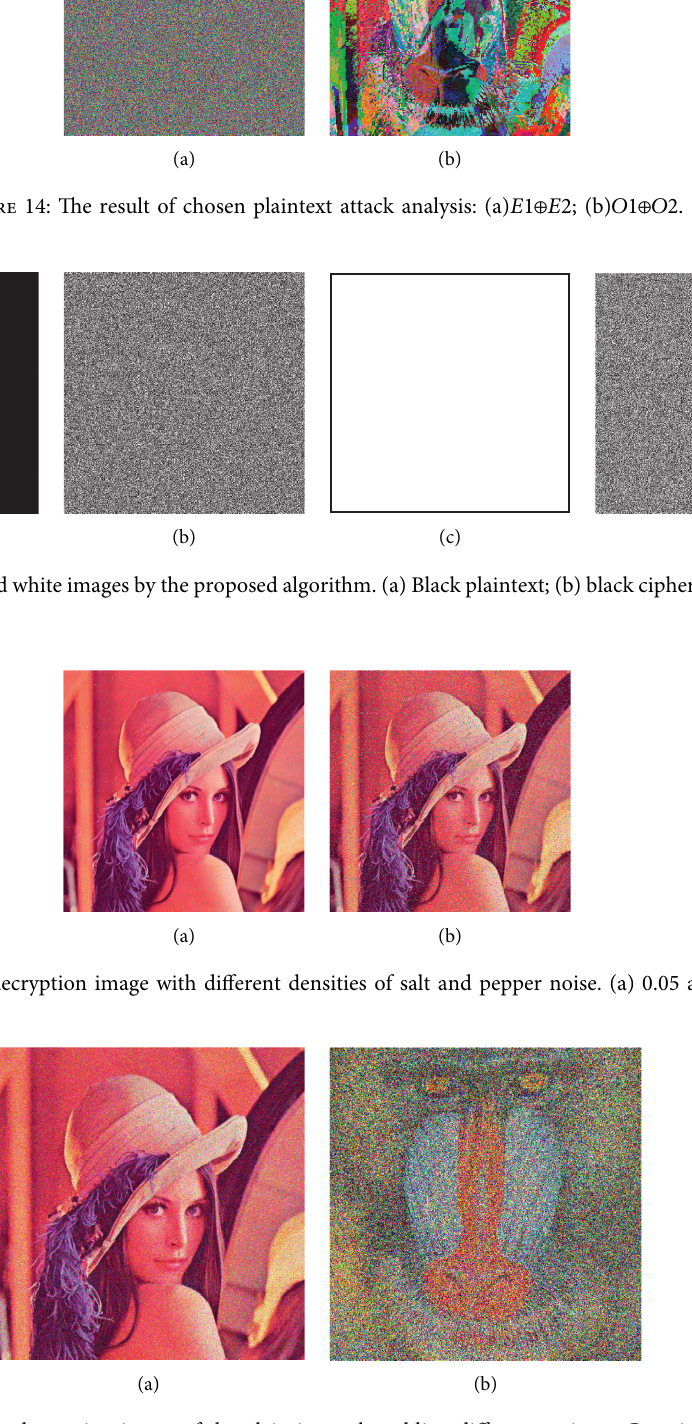
Figure 17: The decryption image of the plain image by adding different variance Gaussian